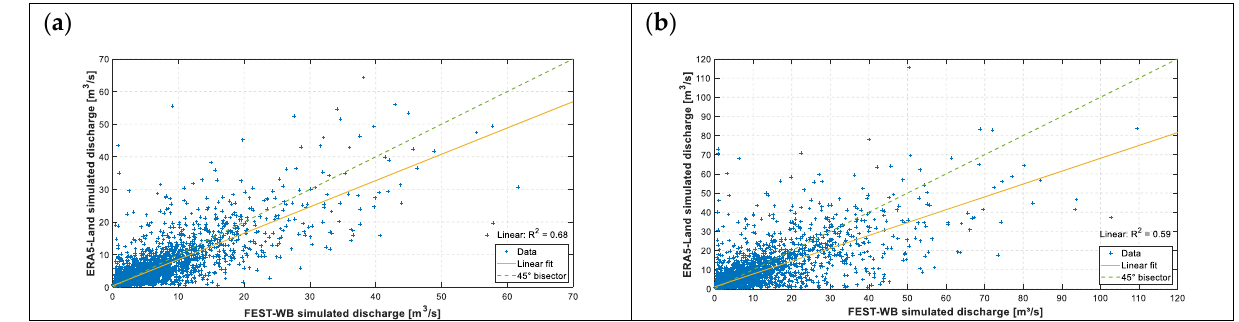
Figure 7. Comparison between simulated runoff by FEST-WB model forced with ERA5-Land ( y -axis) and observed data ( x -axis) for the years 2003–2020: average ( a ) and maximum ( b ) daily discharge values at the Bovisio-Masciago gauge section.